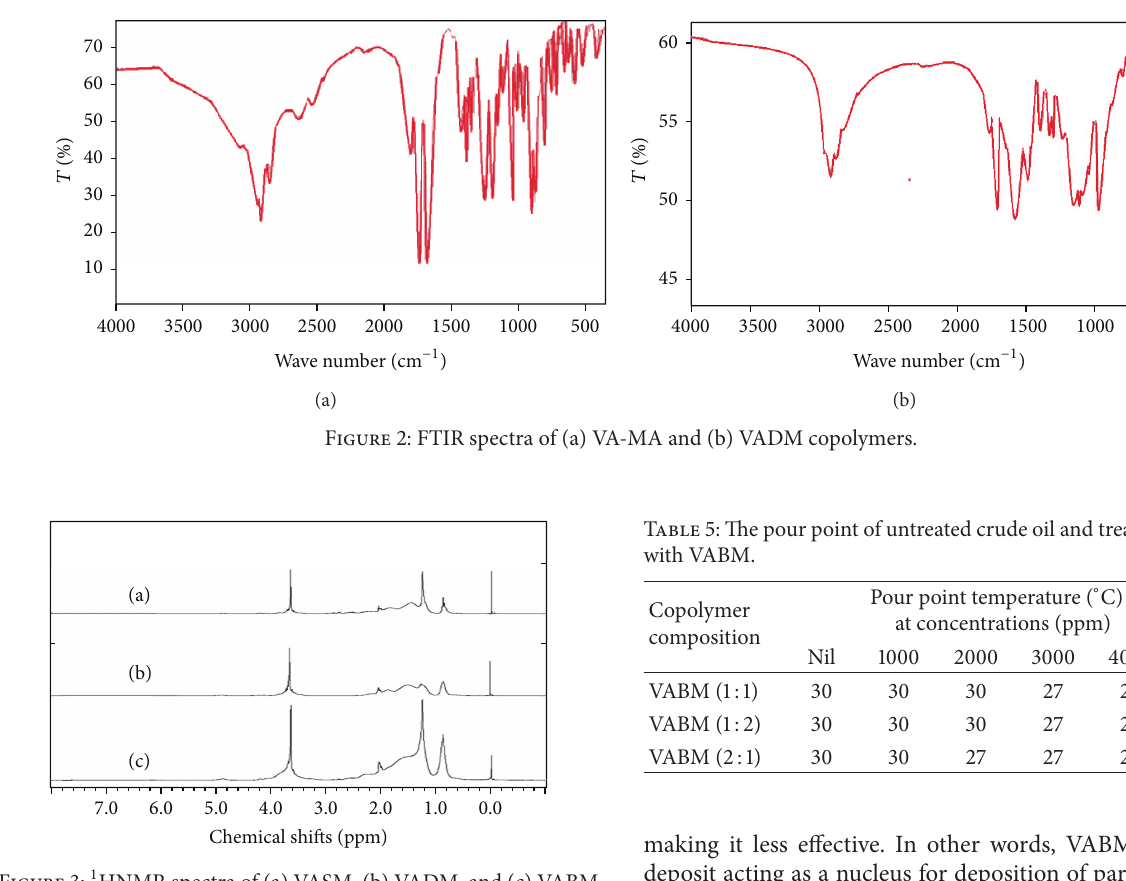
Figure 3: 1 HNMR spectra of (a) VASM, (b) VADM, and (c) VABM copolymers.